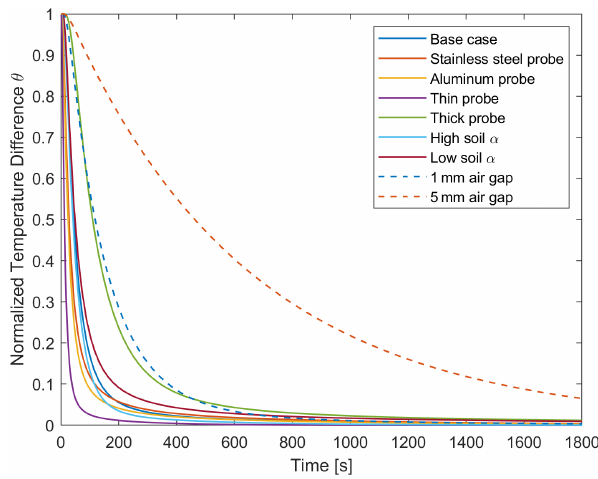
Figure 4. Equilibrium time for various DTP system geometries and environmental